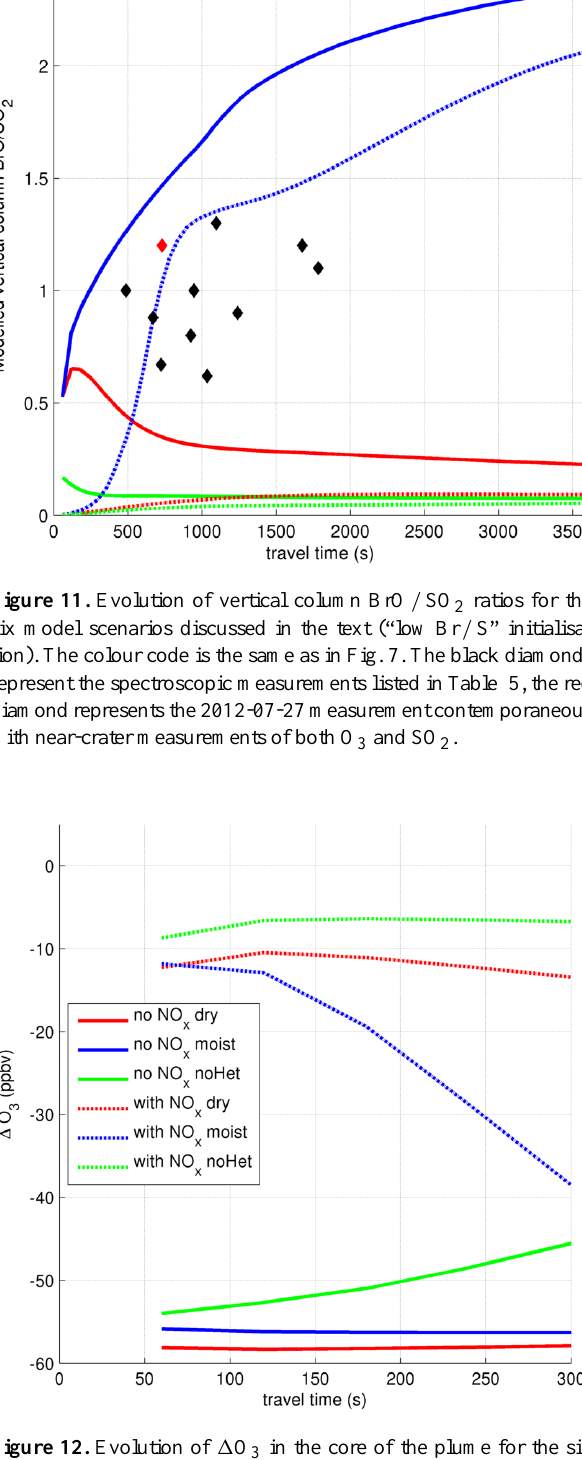
Figure 12. Evolution of (cid:49) O 3 in the core of the plume for the six model scenarios discussed in the text using the “high Br / S” initial- isation. The colour code is the same as in Fig.